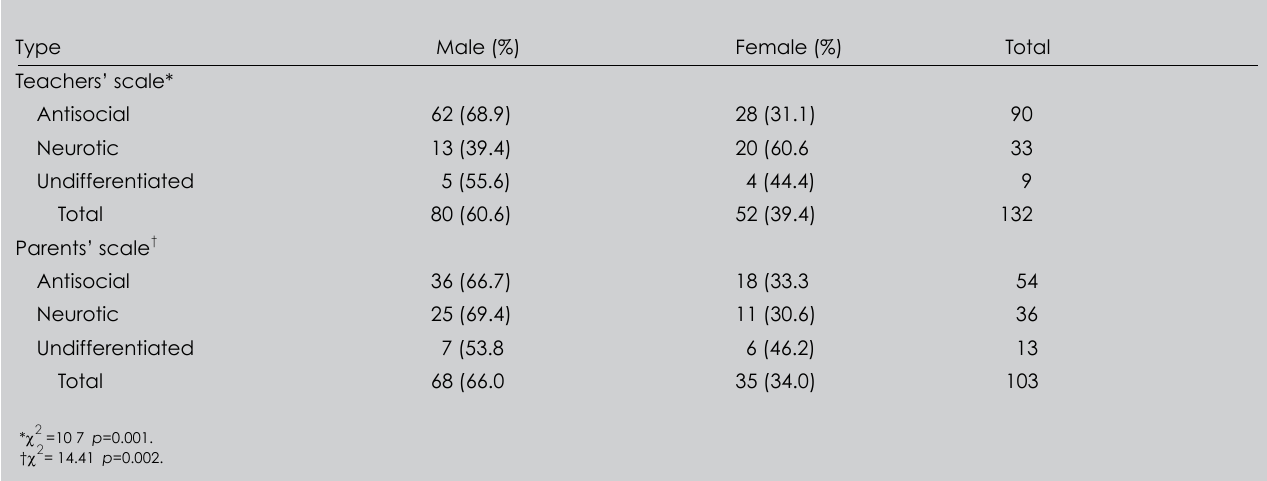
Table IV. Type of behavioural problems according to gender